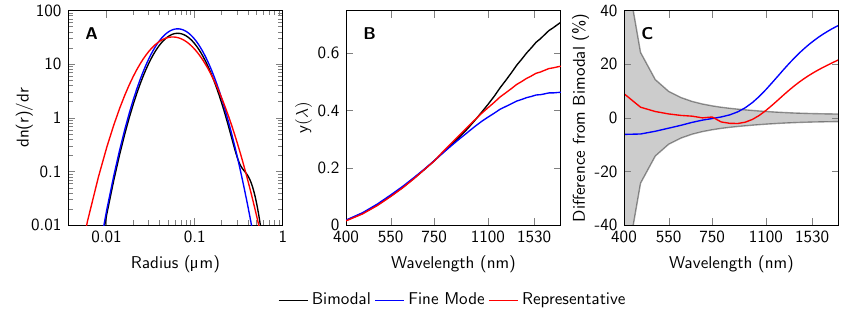
Fig. 4. Modelled sensitivity of the aerosol measurement vectors from scan 6432001 as a function of wavelength for three particle size